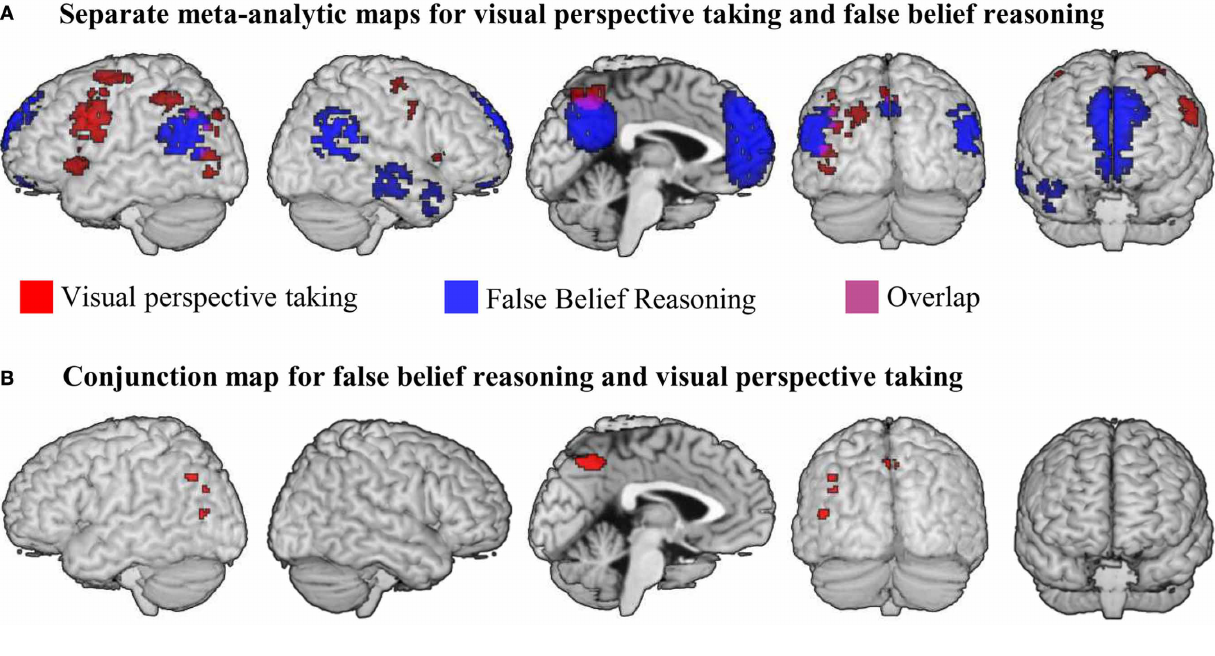
FIGURE 1 | (A) Results of meta-analyses for false belief reasoning (blue) and visual perspective taking (red). Overlap between result maps is shown in purple. (B) Results of a conjunction analysis searching for brain areas active